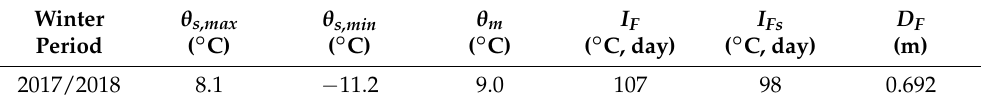
Table 3. Climate parameters of individual winter periods of segment A at the experimental field. Winter Period